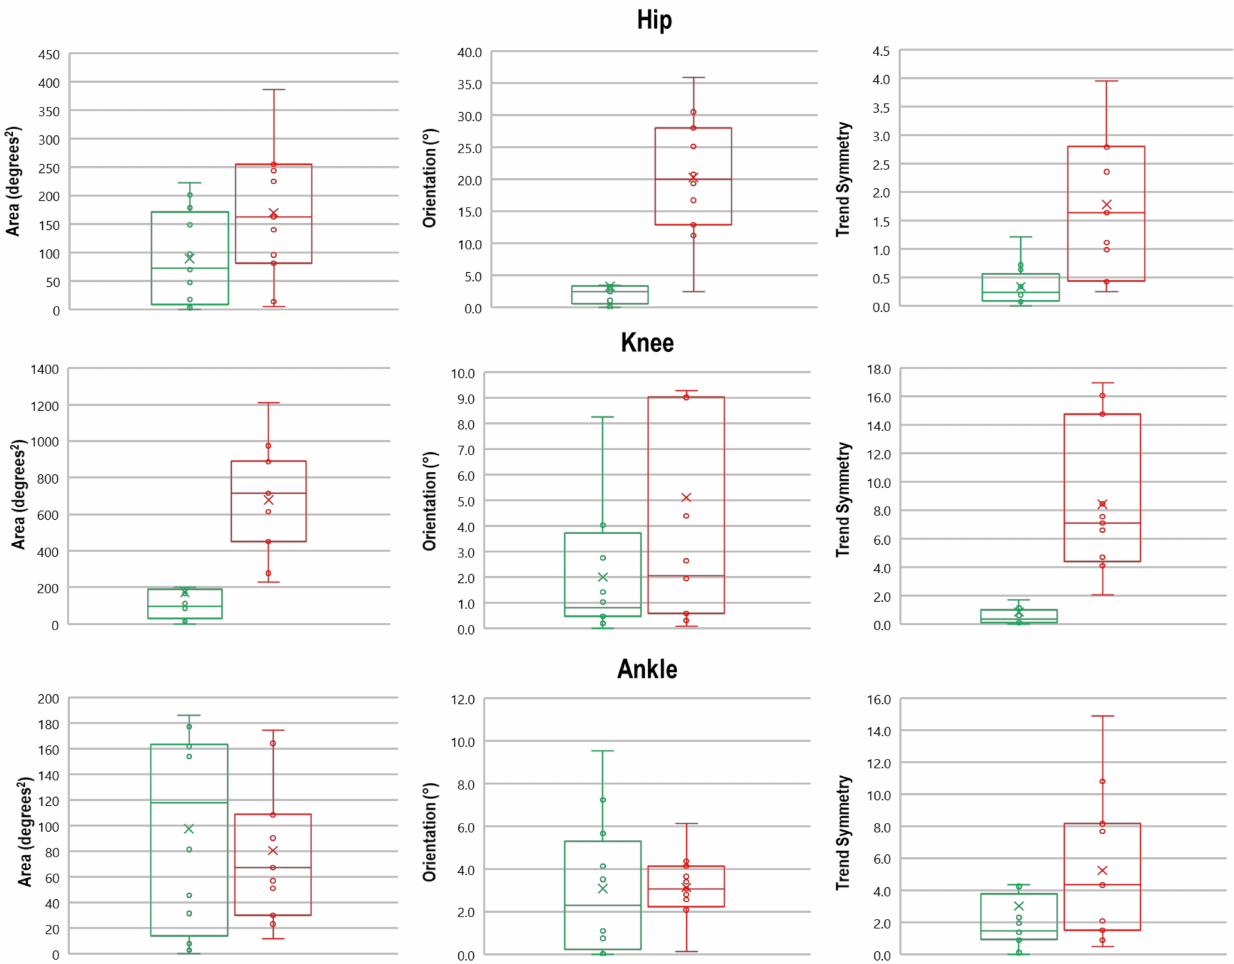
Figure 8. Box plots summarizing Area, Orientation, and Trend Symmetry for hip, knee, and ankle joints. The green line represents the control group and the red line individuals with